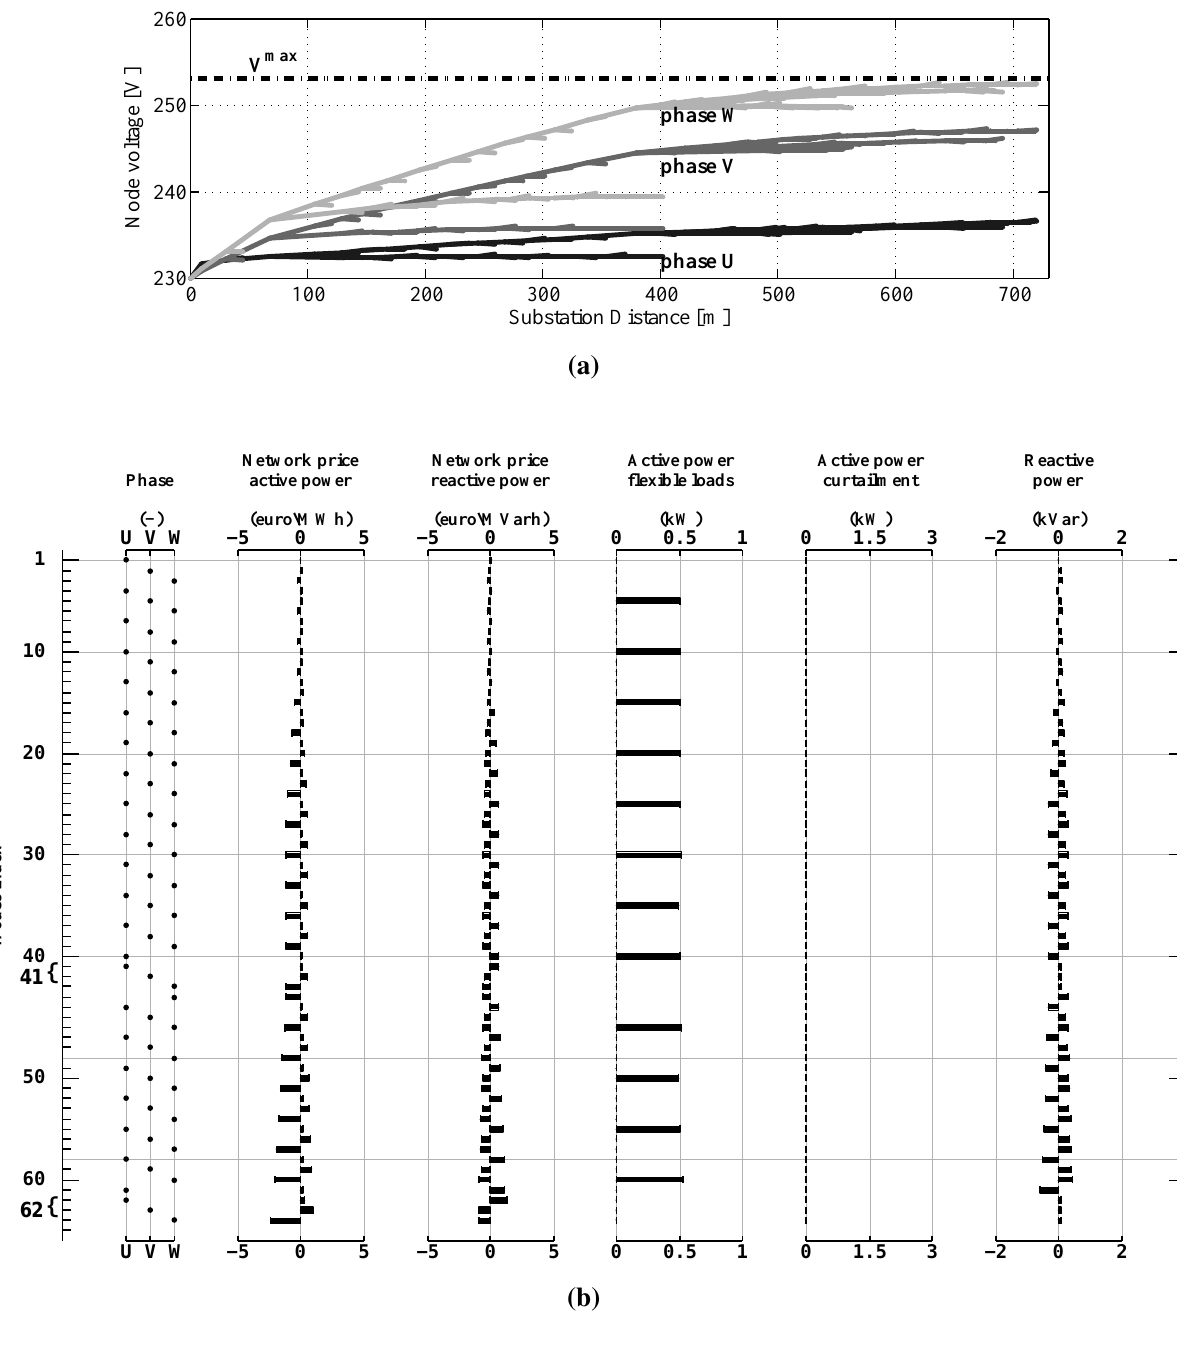
Figure 7. Results of a pricing scheme that gives incentives to adapt flexible consumption or to provide reactive voltage control and to curtail PV power. ( a ) Grid voltages; ( b ) network prices, flexible consumption, curtailed PV power and reactive power provided by PV panels for each node of the